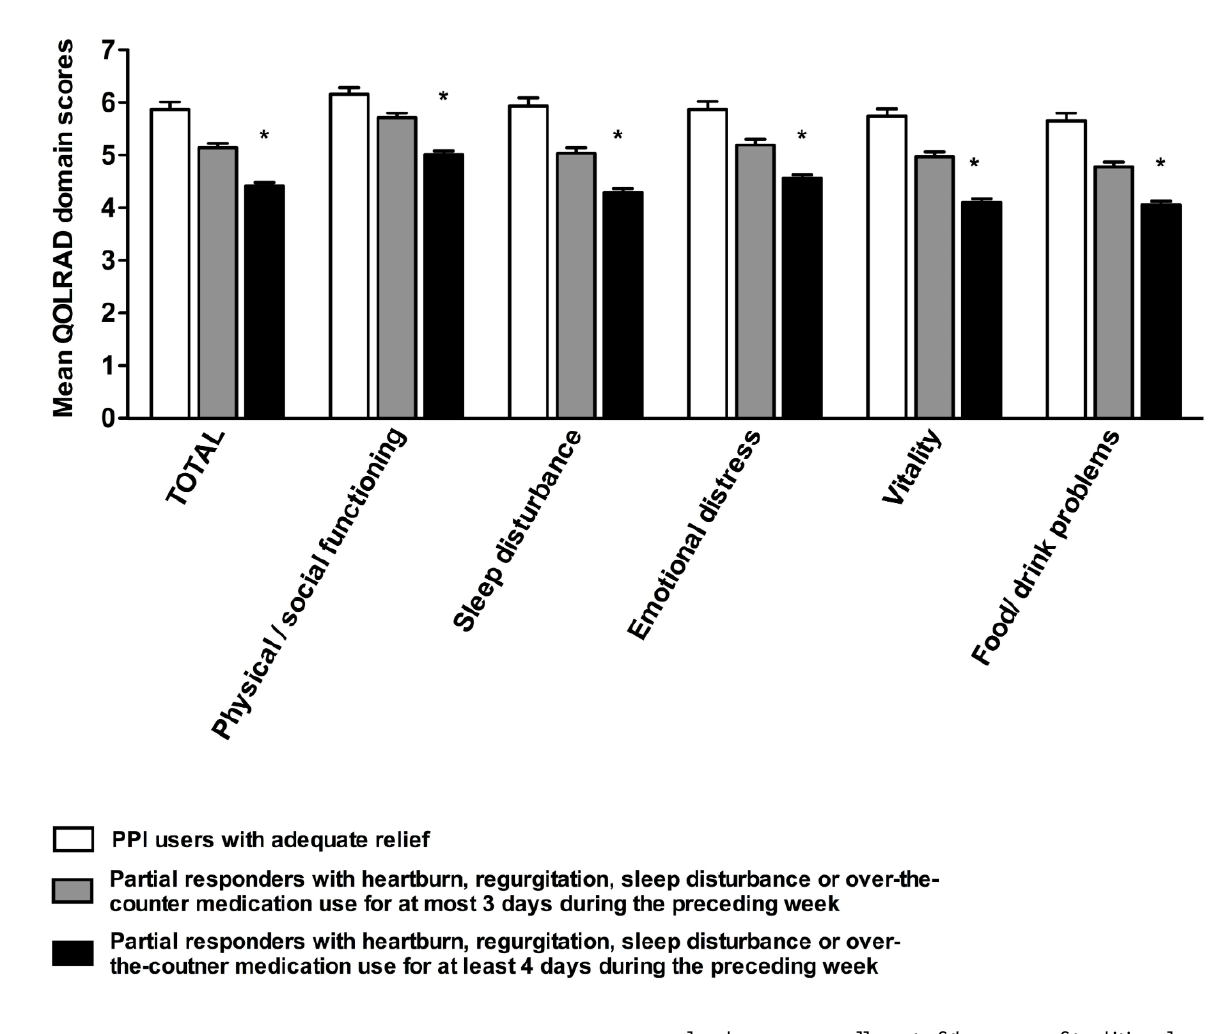
Figure 4. Quality of Life in Reflux and Dyspepsia (QOLRAD) scores by domain in proton pump inhibitor (PPI) users with subdivision of partial responders. * P < .001 for comparison between partial responders with symptoms persisting at most 3 days per week and those with symptoms persisting at least 4 days per weeks. Error bars indicate